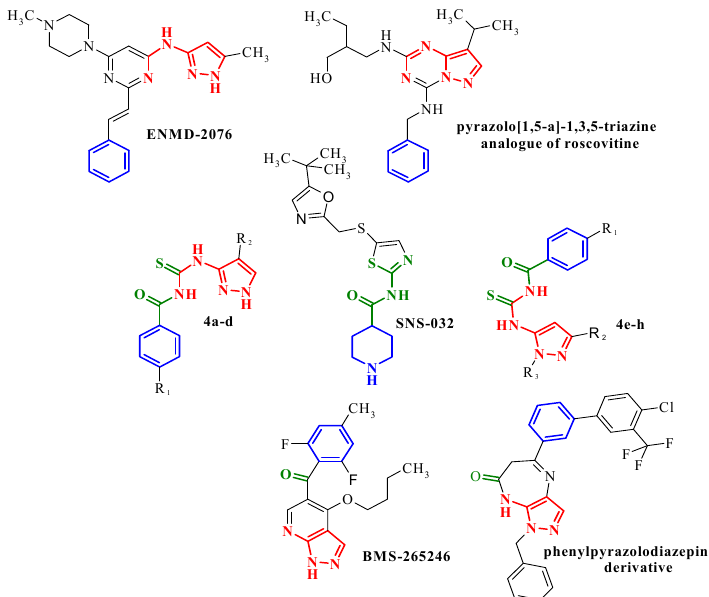
Figure 2. The structural design of the new compounds 4a – h based on the aminopyrazole, thiourea and phenyl